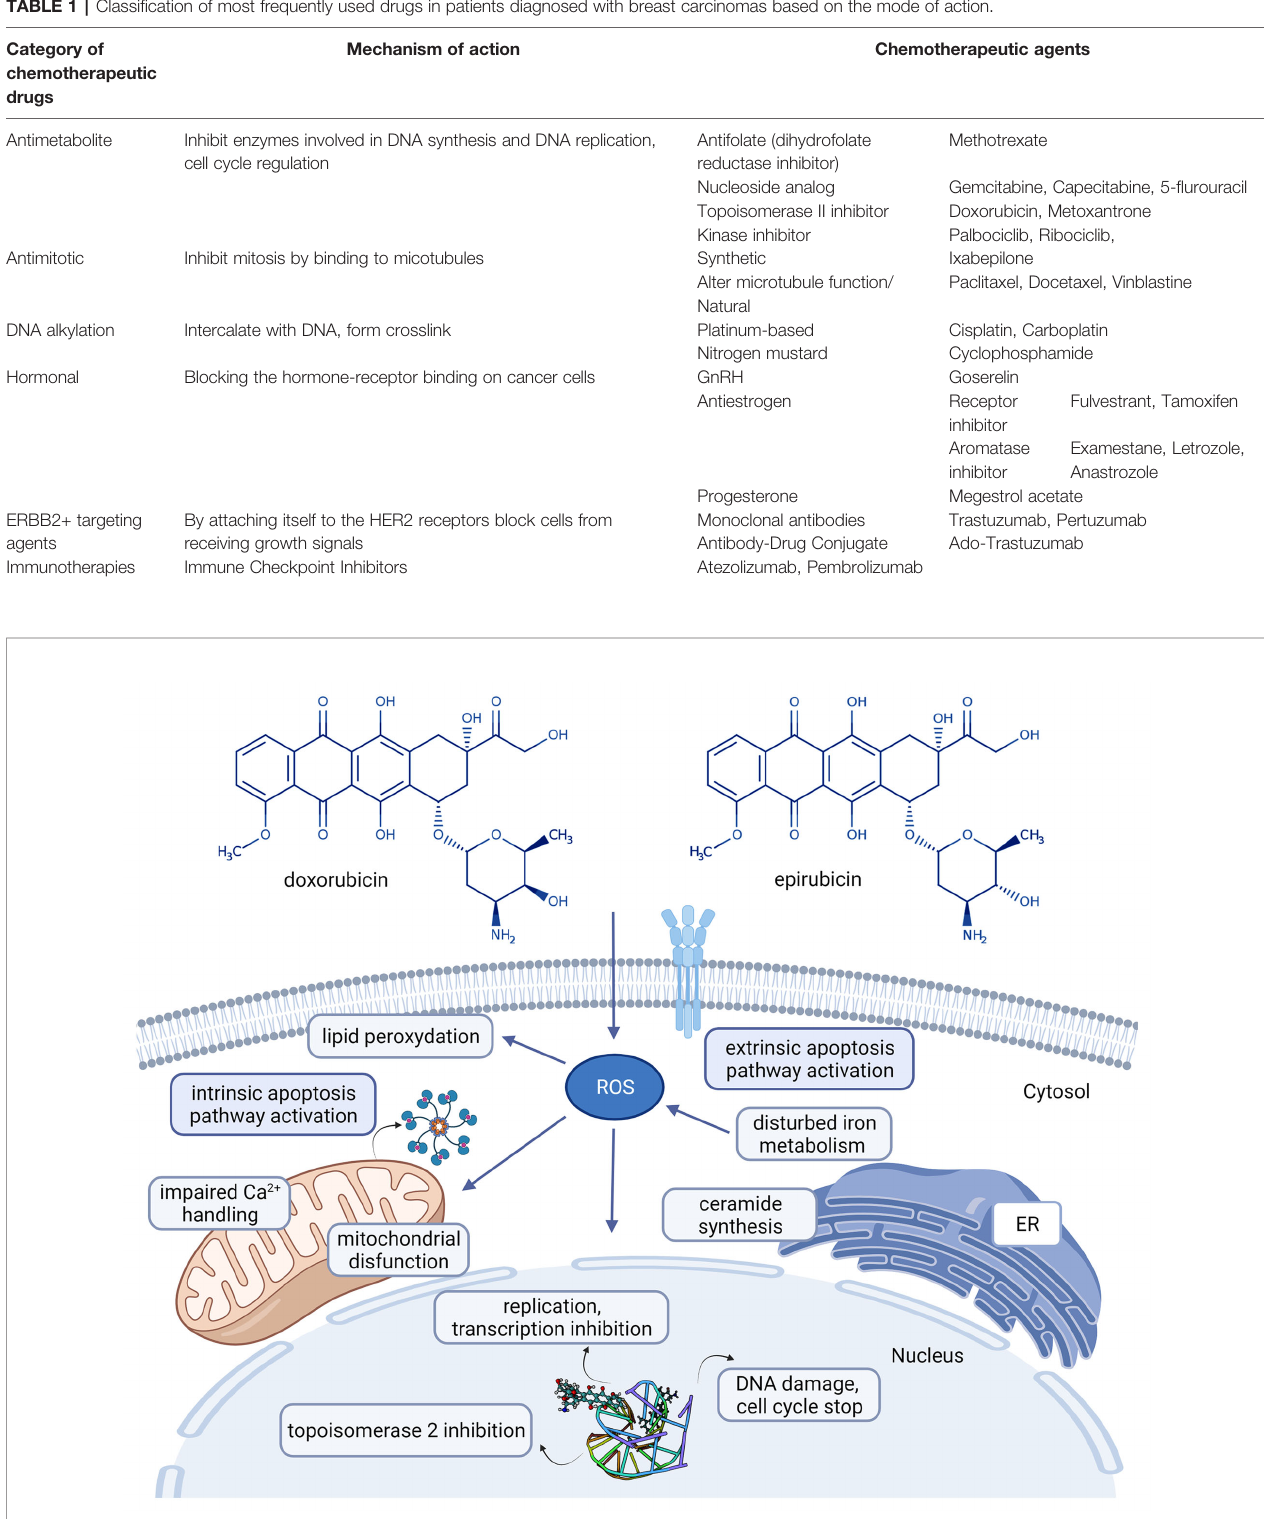
FIGURE 1 | Chemical structures of the clinically used anthracyclines in breast cancer treatment and their mechanism of action [doxorubicin: CHEBI:28748, epirubicin CHEBI:47898 (14), adriamycin-DNA interaction: PDB ID 6KN4 (15)]. Created with BioRender.com. Agreement number: UB23MRCQE9.